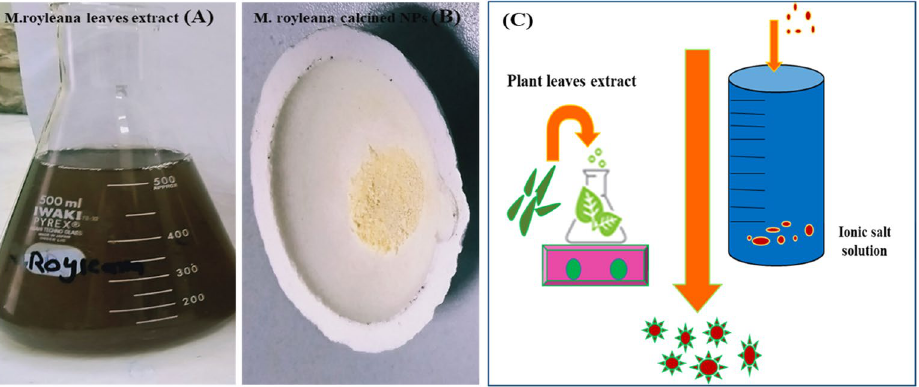
Figure 1. ( A ) Aqueous extract of Mentha royleana , ( B ) Calcined CeONPs at 400 C 0 for 2 h, ( C ) Schematic representation of the general process of green synthesized CeONPs